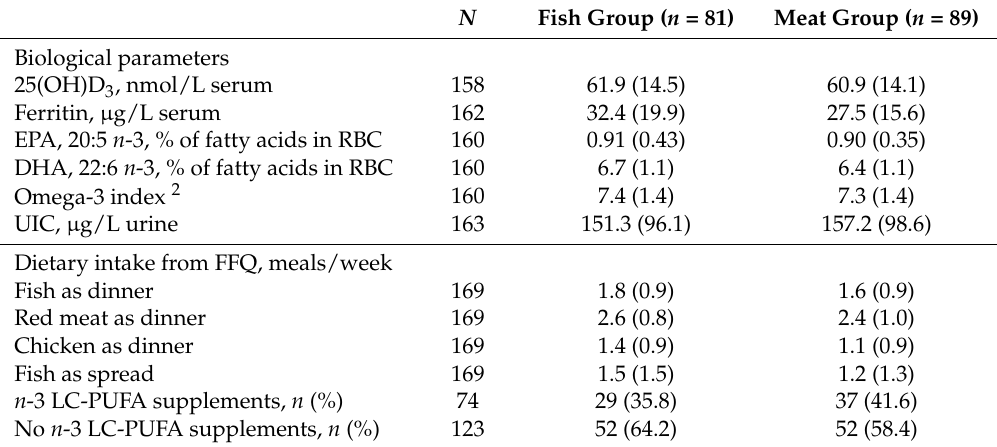
Table 2. Predicted changes in parent-reported mental health measured by the Strengths and Difficulties